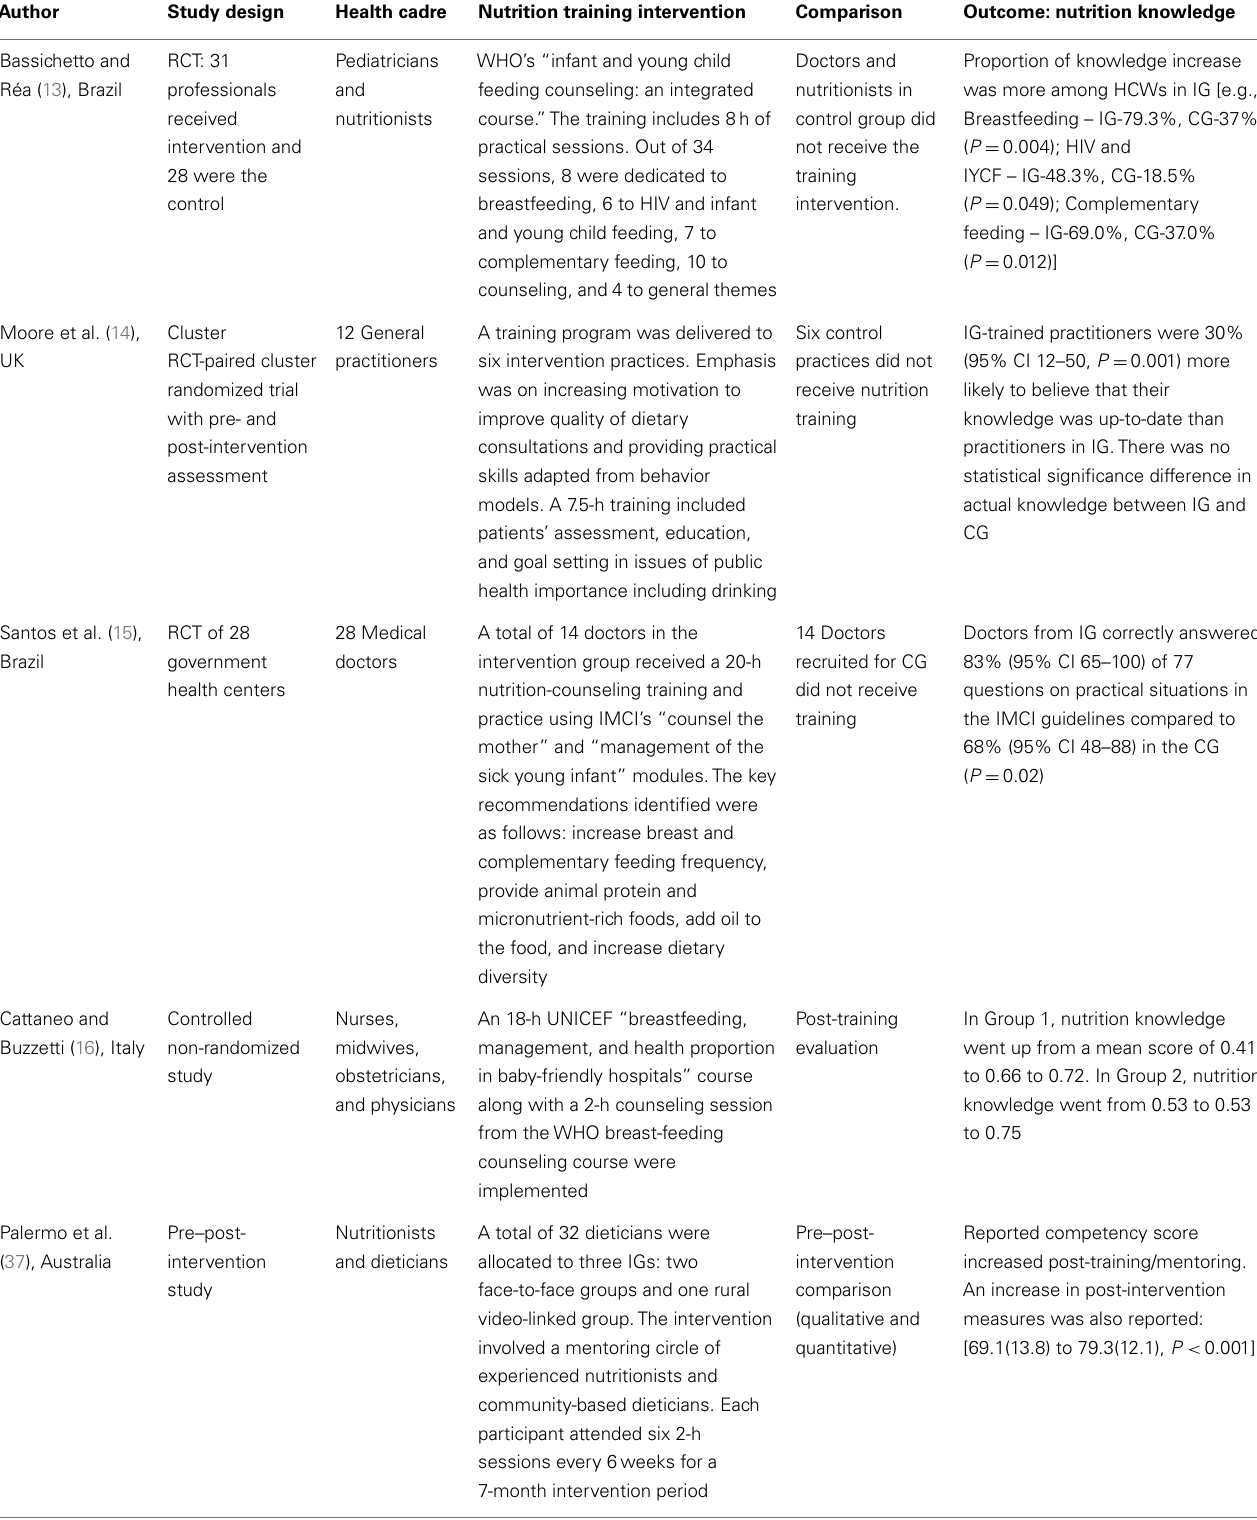
Table 5 |The effectiveness of nutrition training to improve nutrition knowledge of health care